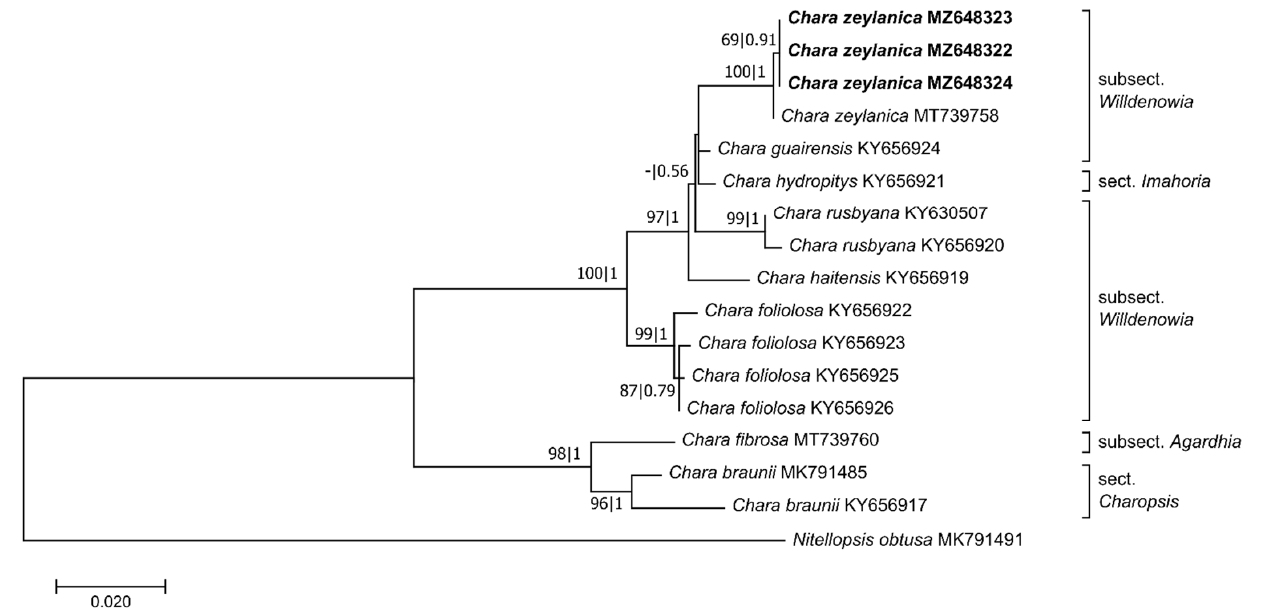
Figure 4. Phylogenetic tree based on 970 base pairs (bp) of the matK sequences. The evolutionary history was inferred using the GTR+G+I model. Maximum likelihood bootstrap values (>50%, ML, left ) and Bayesian posterior probabilities (>0.5, BI, right ) are given at the branches. The scale indicates sequence divergence in percent. The specimens collected in Sardinia are marked bold. Information about the section and the subsection of the species is given at the tree [24,29,53].